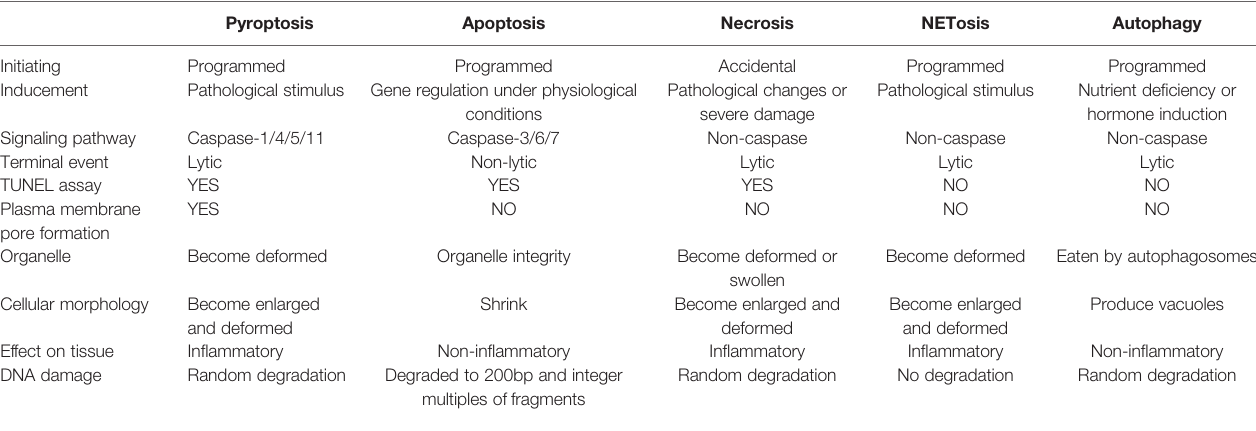
TABLE 1 | Comparison of different cell death